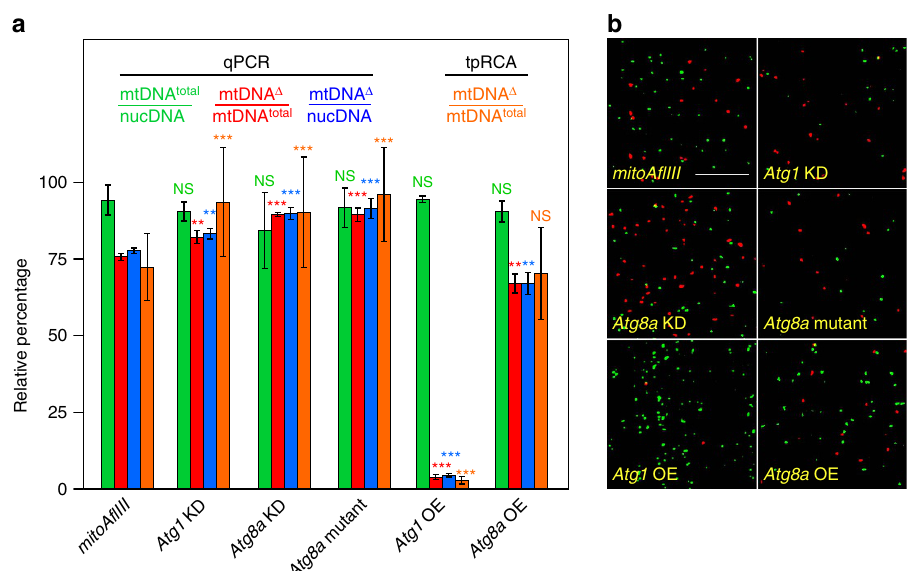
Figure 5 | Atg1 and Atg8a promote selective removal of mtDNA D . All data presented are derived from Supplementary Table 3. ( a ) Relative abundance of different mtDNA species determined using qPCR and tpRCA. Bars depict mean ± 1 s.d. Supplementary Table 3 shows numbers of biological replicates. ( b ) Images from flight muscle of the indicated genotypes, hybridized for tpRCA as in Fig. 3. Scale bar, 10 m M. Statistical significance is estimated as compared with levels of the corresponding species in mitoAflIII flies using Student’s t- test with unequal variance. NS P 4 0.05, ** P o 0.01 and *** P o 0.001. Note that number of nucleoids labelled in each sample in b is not reflective of total muscle mtDNA levels, which are estimated in a using qPCR and comparisons with nuclear DNA (mtDNA total /nucDNA). NS, not significant.